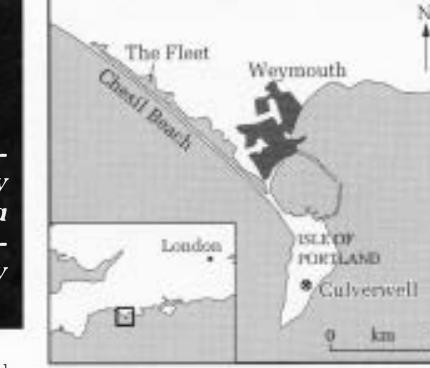
Figure 1 Location of the Isle of Portland and the Culverwell midden